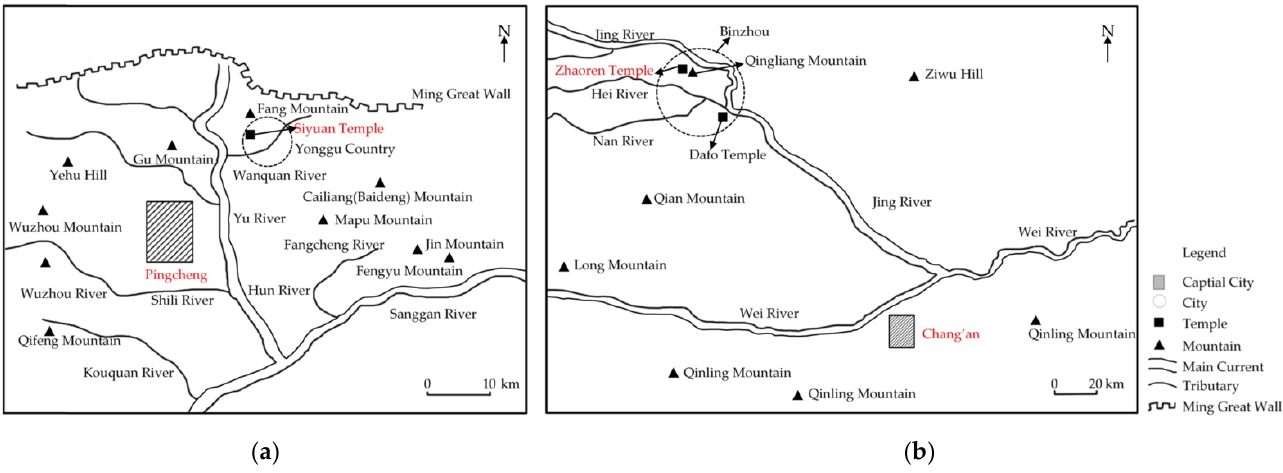
Figure 2. The relationship between the temples and cities on a macro scale. ( a ) The Siyuan Temple, Pingcheng and surroundings; ( b ) the Zhaoren Temple, Chang’an, and surroundings.